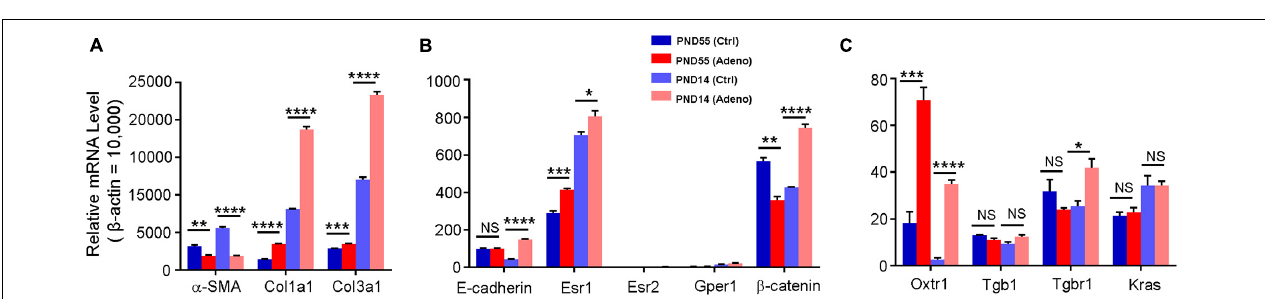
FIGURE 3 | Changes in gene expression in adenomyotic uteri in neonatal and adult mice. mRNA for each gene was quantified by qPCR; the expression level was calculated using the 2 - (cid:49) Ct method and was normalized against β –actin. Genes are grouped and plotted in panels (A–C) , according to their relative expression levels. Note that α -SMA, Col1a1, Col3a1, Esr1, and Oxtr1 were changed in the same direction in both age groups, while E-cadherin and Tgbr1 were up-regulated only at PND14, and β -catenin was changed in the opposite direction between two groups. N.S., no statistical significance, * P < 0.05, ** P < 0.01, *** P < 0.001, **** P < 0.0001 with unpaired Student’s t -test ( N = 3 repeats in A–C with 3 (adult) or 9 (neonate) mice in each repeat). Ctrl, vehicle treatment; Adeno, tamoxifen treatment; PND, postnatal day.